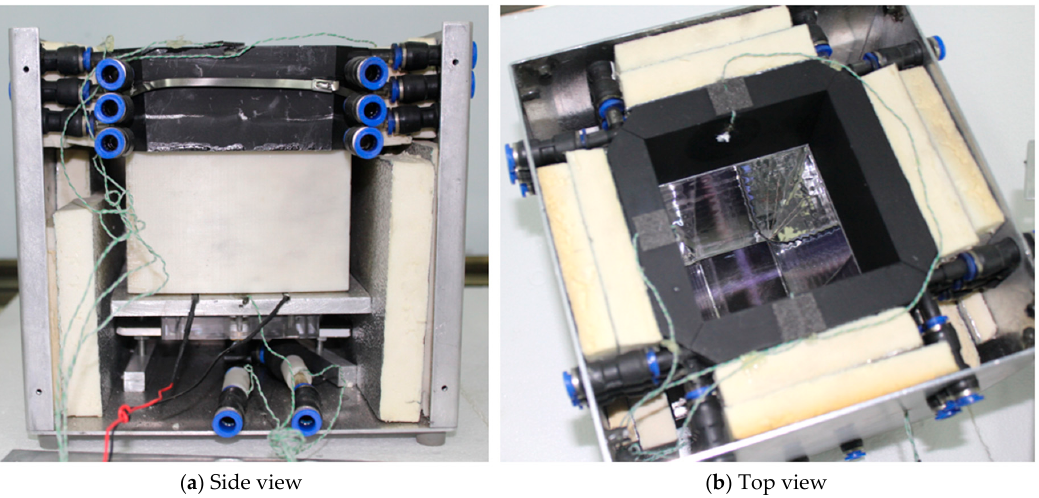
Figure 9. ( a ) A view from side of the module. ( b ) A top view of the module before glass cover added. A thermocouple attached to the absorber wall is visible.